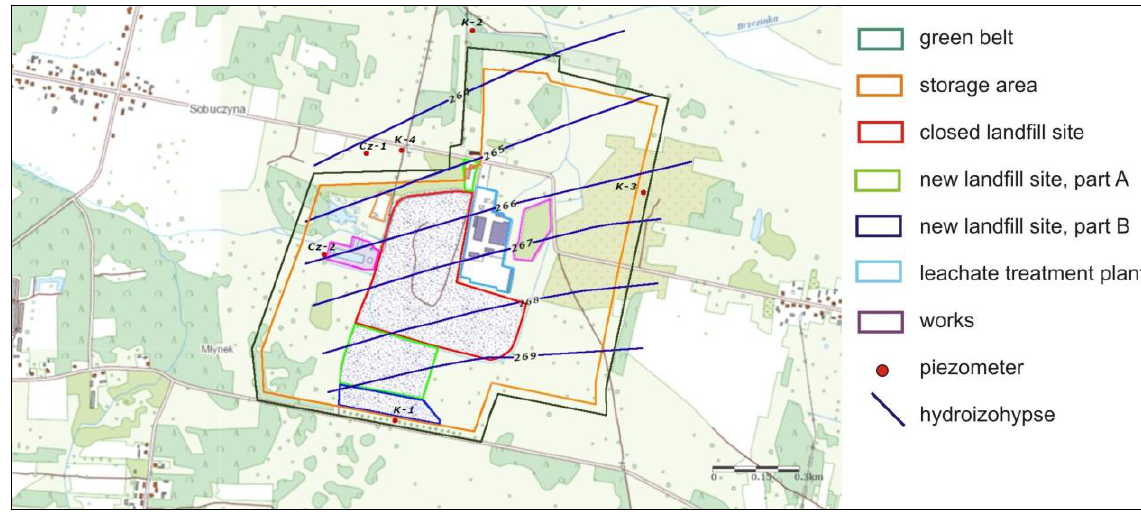
Fig. 1. Map of the study area (based on Topuszczak,